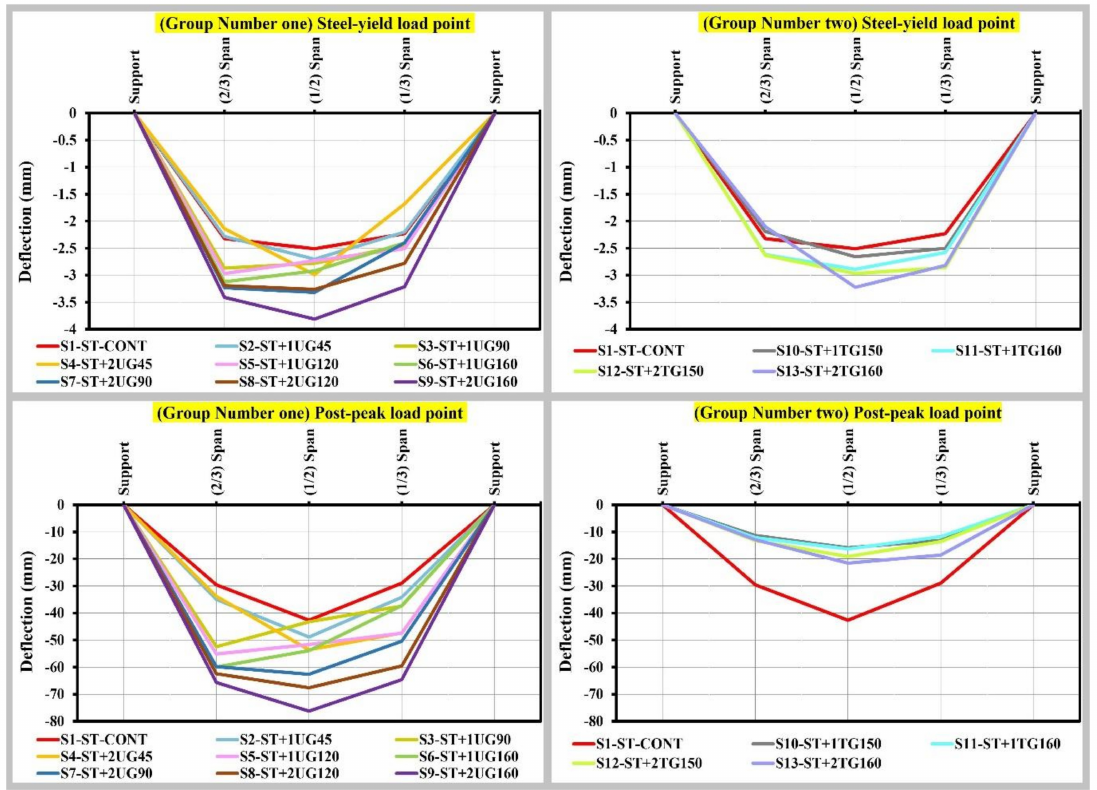
Figure 9. Concrete slabs deflection patterns at concrete slabs critical load points in comparison to the concrete control